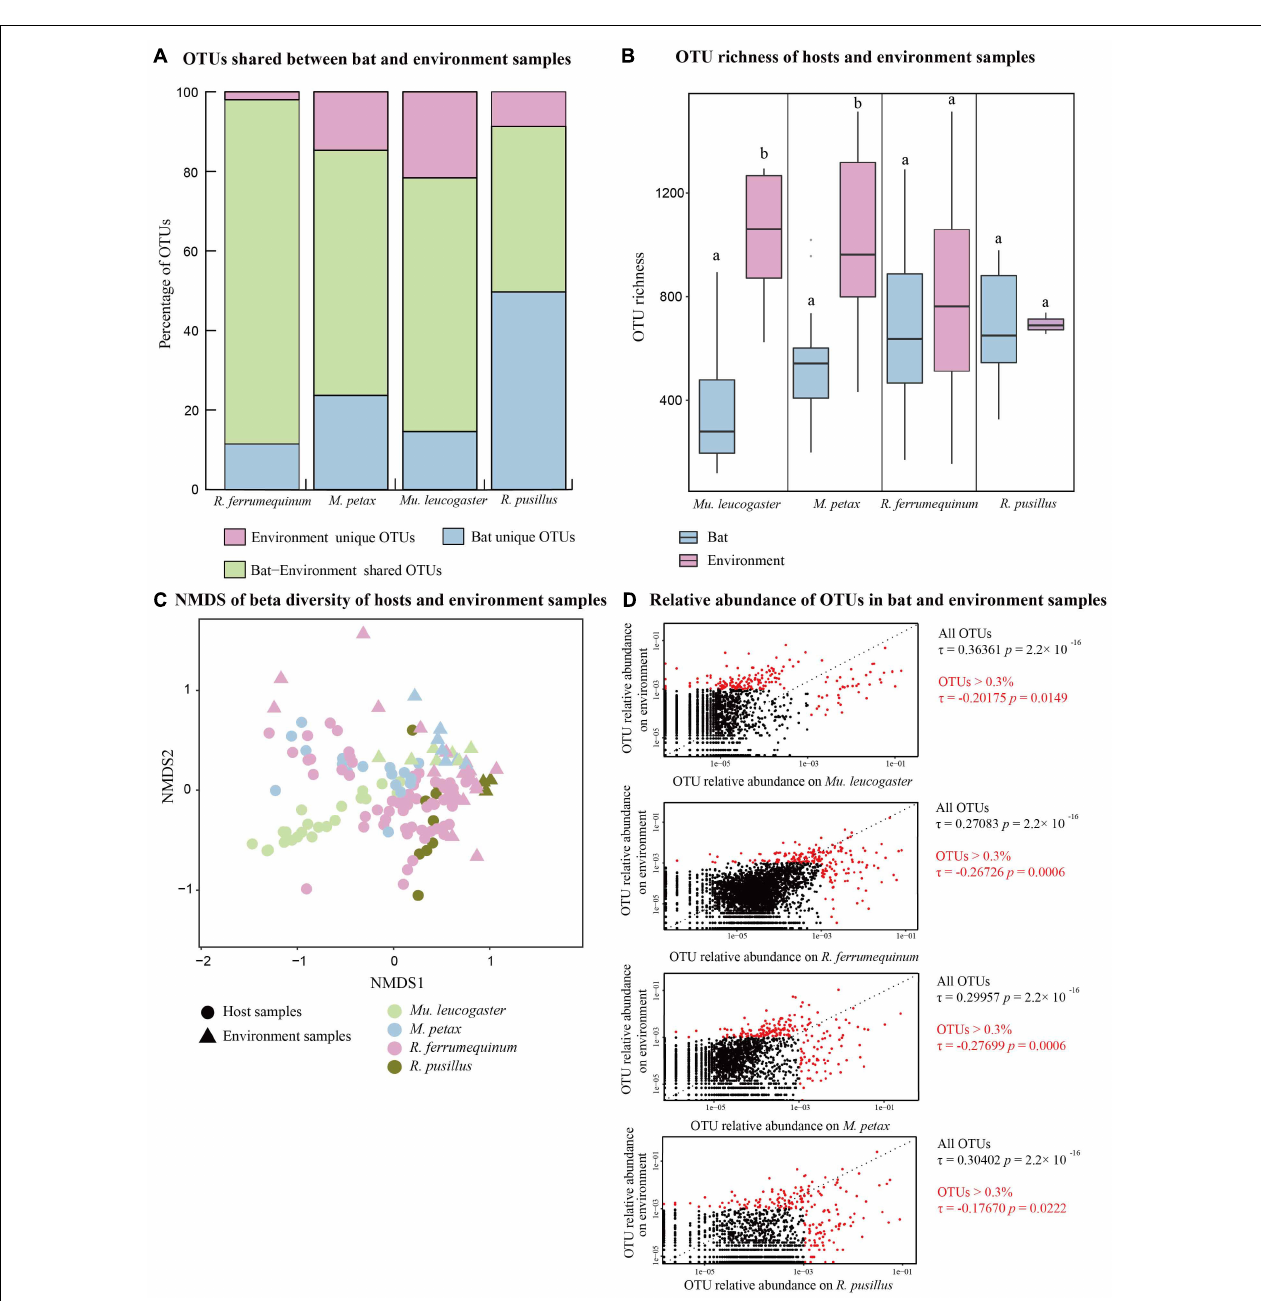
FIGURE 1 | Bat skin and environment bacterial communities of four bat species across five sites. (A) Percentage of shared and unique Operational Taxonomic Units (OTUs) of each bat species and environment samples. (B) OTU richness of hosts and environment samples. Letters represent significant differences among groups. (C) Beta diversities of bat and environment samples. Non-metric multidimensional scaling analysis of Bray Curtis distances. (D) Relative abundances of OTUs on each bat species and its corresponding environment samples. Red dots show OTUs with a total relative abundance > 0.3%. Kendall’s ranked correlations, R Tau , and P -values are shown to the right of each